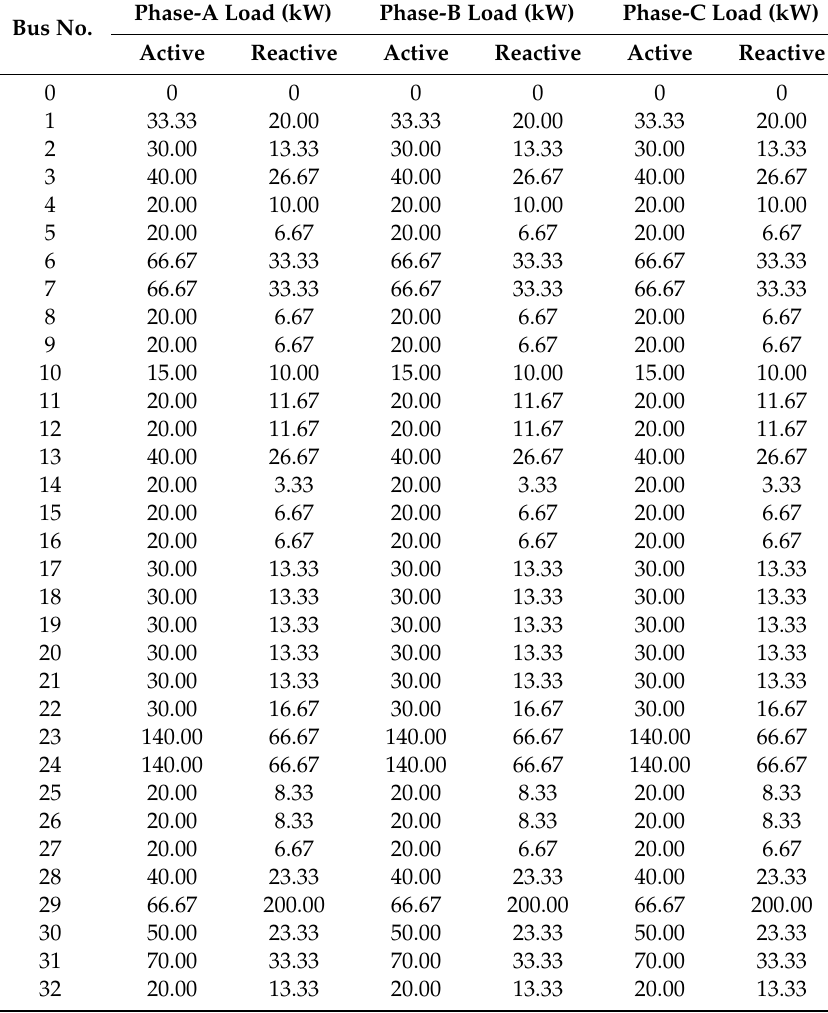
Table A1. Electricity power subsystem